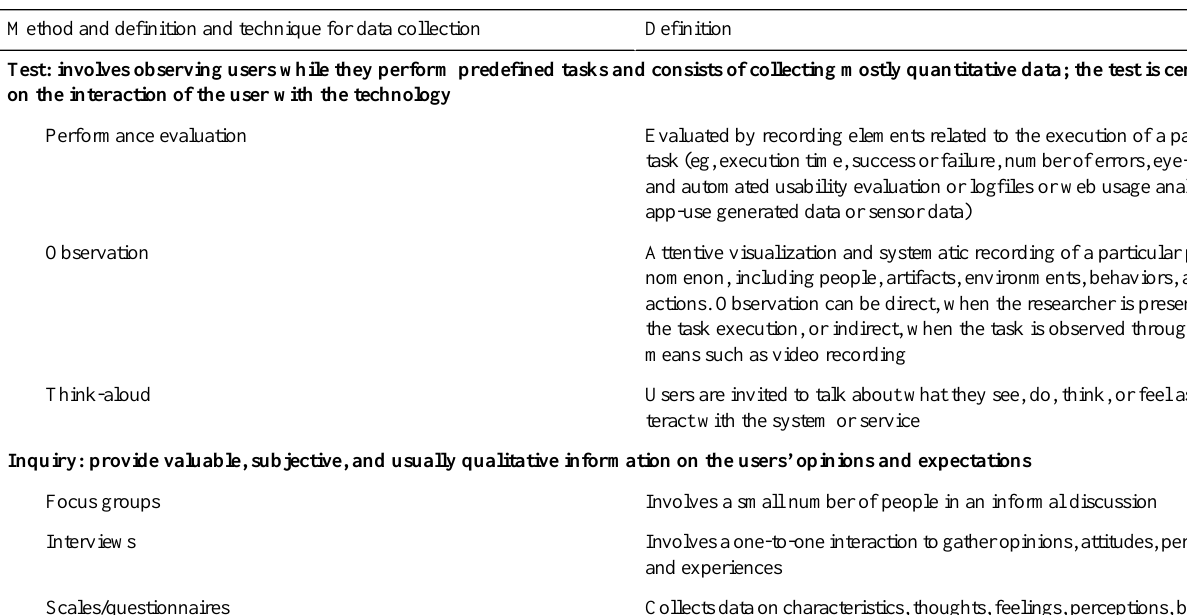
Table 1. Methods of user-centered usability